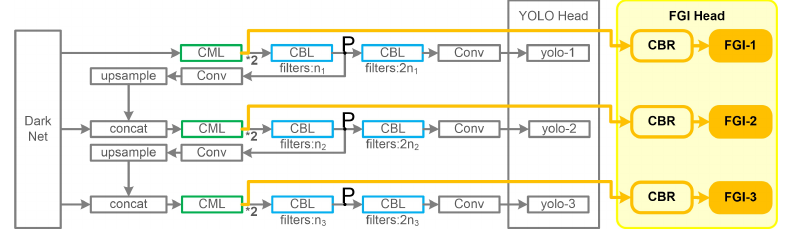
Figure 6. YOLOv3 with FGI Head